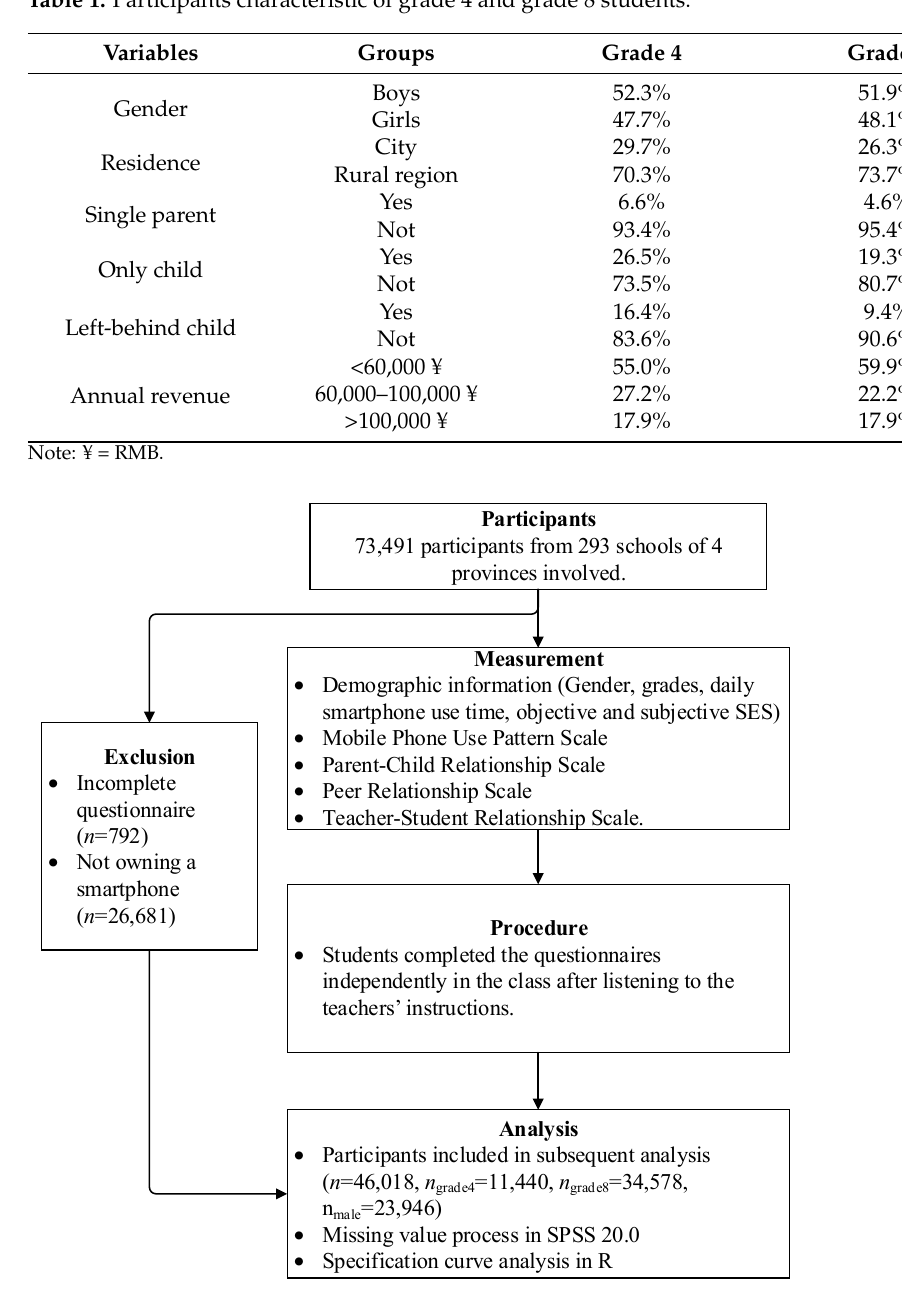
Figure 1. Overall research methodological procedure. Table 1. Participants characteristic of grade 4 and grade 8 students.